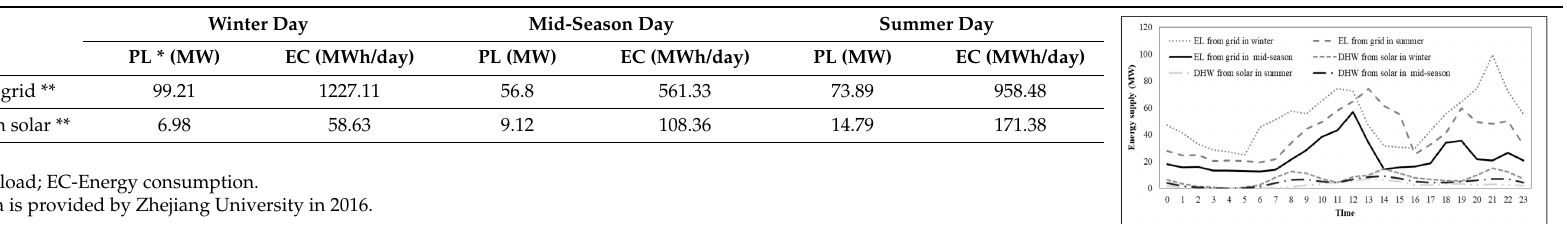
Table 2. Energy demands and load profiles for Xizhou town on three representative